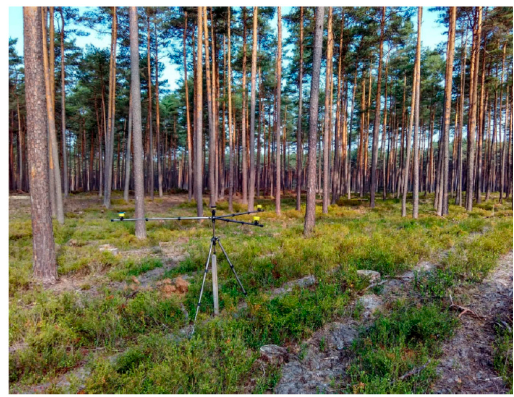
Figure 3. Illustration of Postex technology for georeferencing the position of each plot.